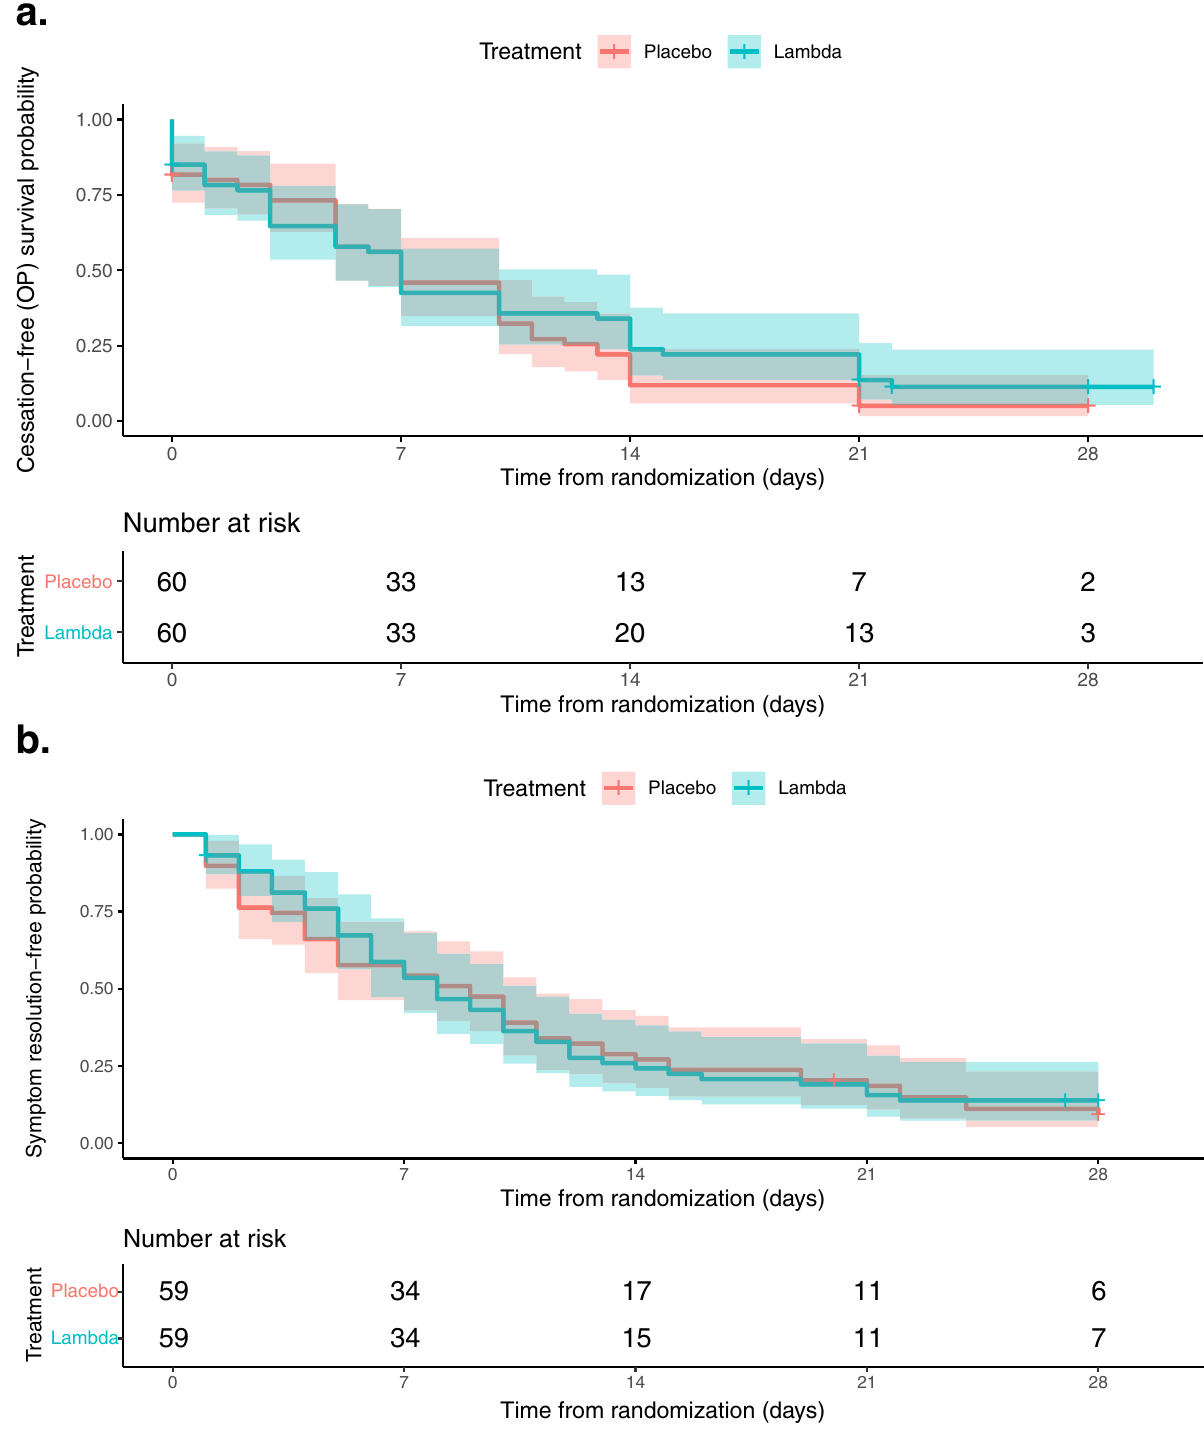
Fig. 2 Kaplan – Meier analyses of the primary and key secondary outcome in the intention-to-treat population. a Time until cessation of SARS-CoV-2 viral shedding from oropharyngeal swabs strati fi ed by treatment arm, Lambda (blue) vs. placebo (red). b Time until resolution of all symptoms strati fi ed by treatment arm, Lambda (blue) vs. placebo (red). In both panels, solid lines represent Kaplan – Meier survival probability; shading represents 95% con fi dence intervals. Source data available at